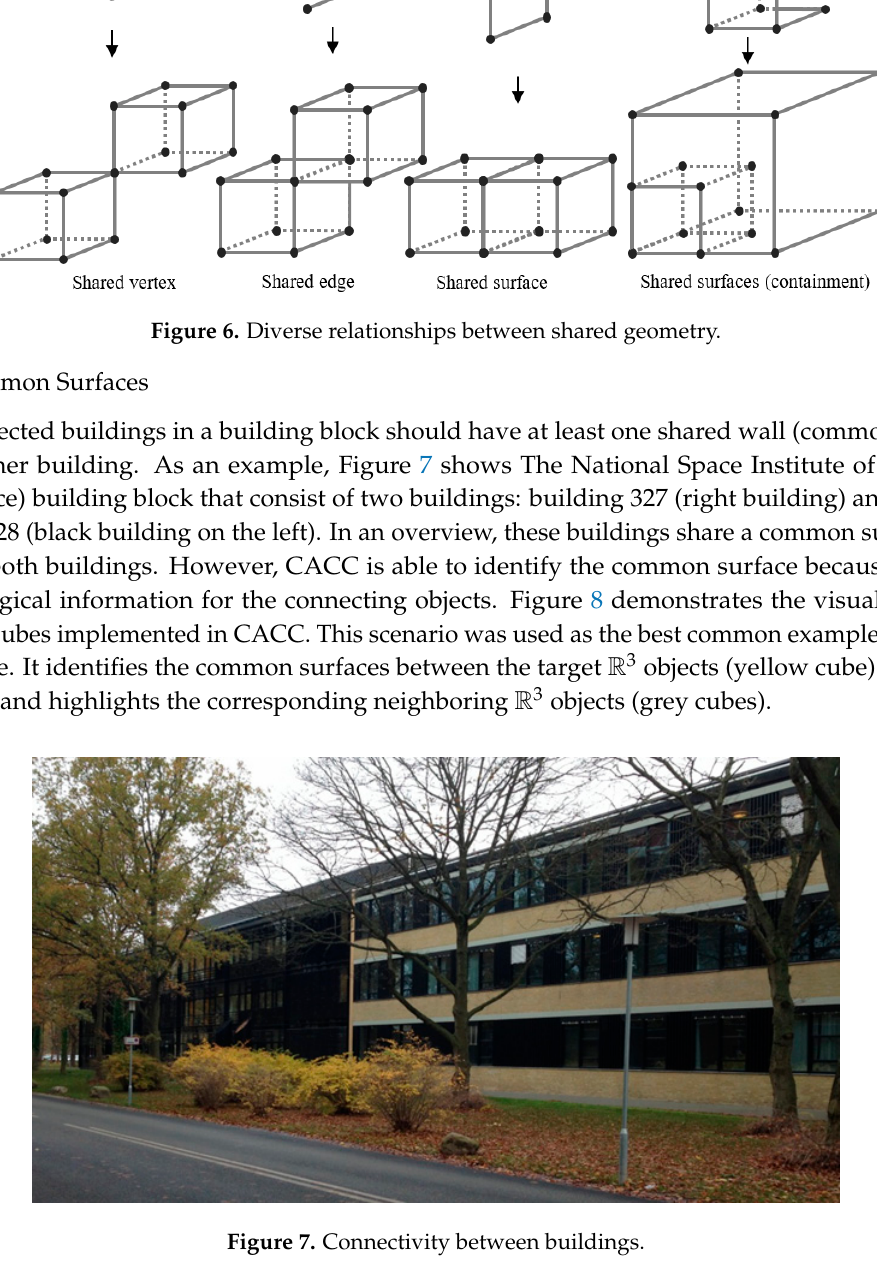
Figure 8. Neighboring objects that share common surfaces. 4.1.2. Common Edges and Vertices In ℝ 3 space, there are possibilities for objects to have a topological relationship with lower dimensional objects (as illustrated in Figure 6). These relationships are stored in CACC. Figure 9 shows the common edges and vertices stored in CACC for ℝ 3 objects. This is achieved by finding the α i -cycles that share corresponding α i-1 -cycles. Figure 9. Common edge and vertex. 4.1.3. Containment Another advantage obtained by implementing CACC is the containment condition. Containment for an object (j) and another object (i) can be seen as j ∩ i or j ∪ i. This is useful for spatial